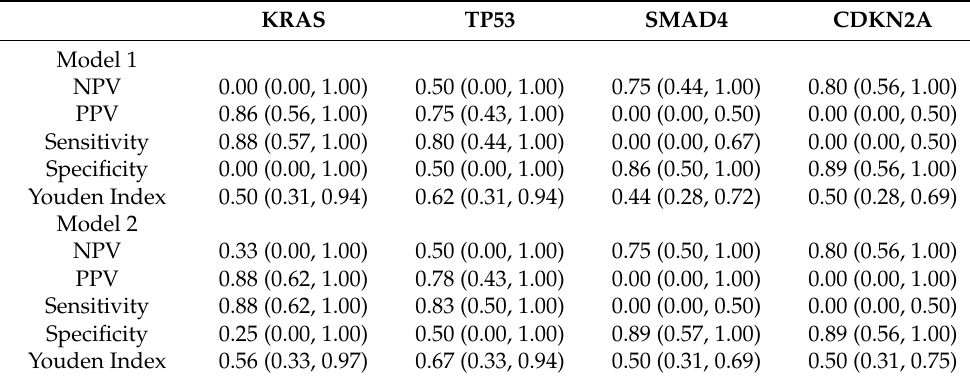
Table 4. Statistical parameters (median and 95% CI) for method 1 and method 2 across the cross- validation